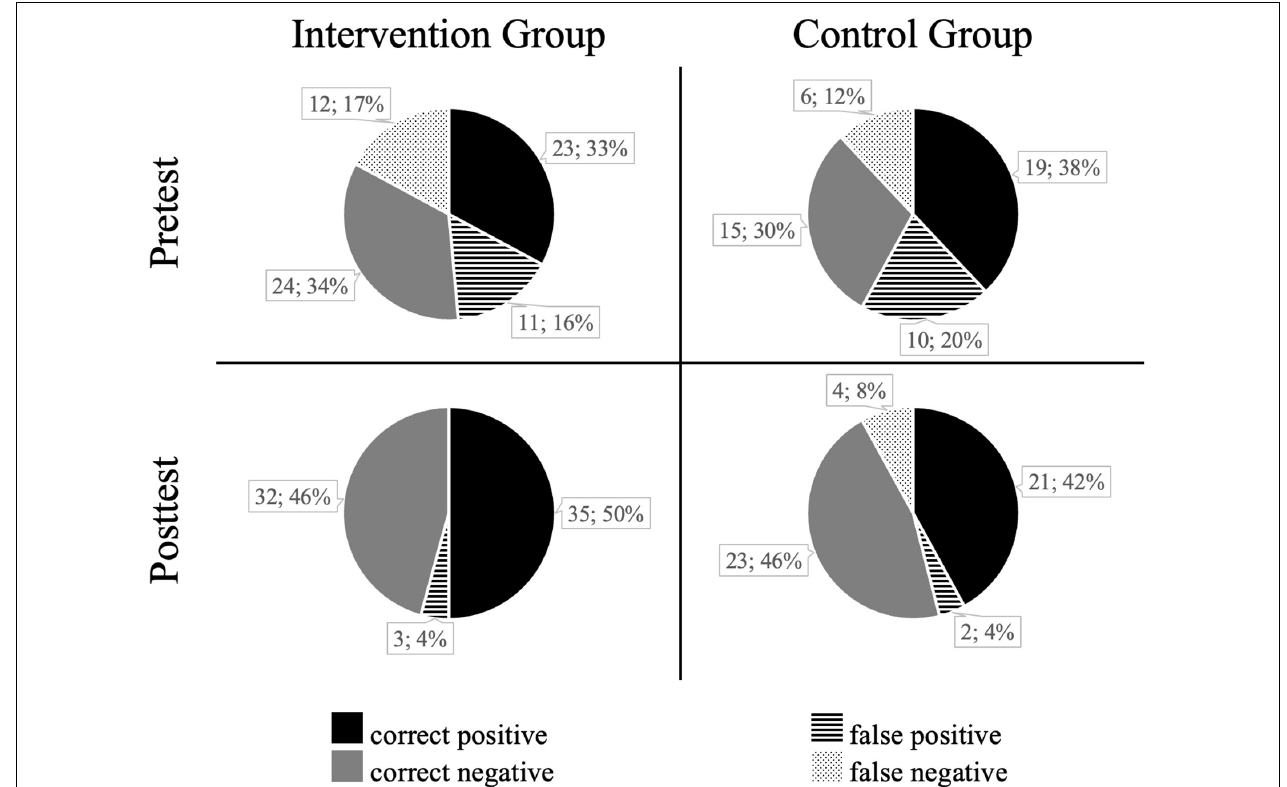
FIGURE 5 | Both groups’ shoot/don’t-shoot